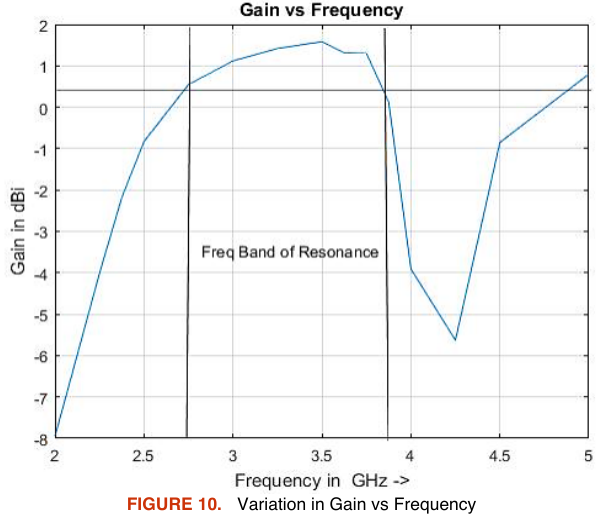
FIGURE 10. Variation in Gain vs Frequency